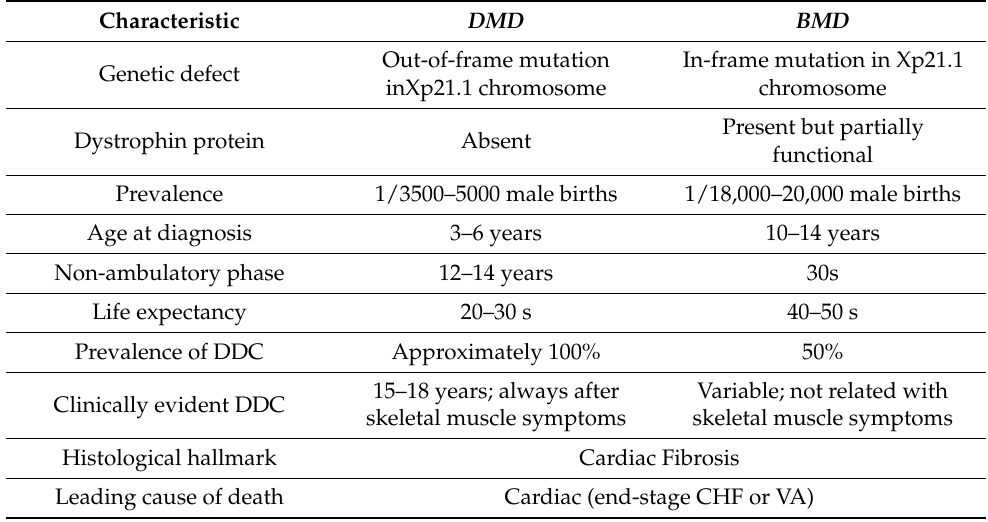
Table 1. Differences between DMD and BMD